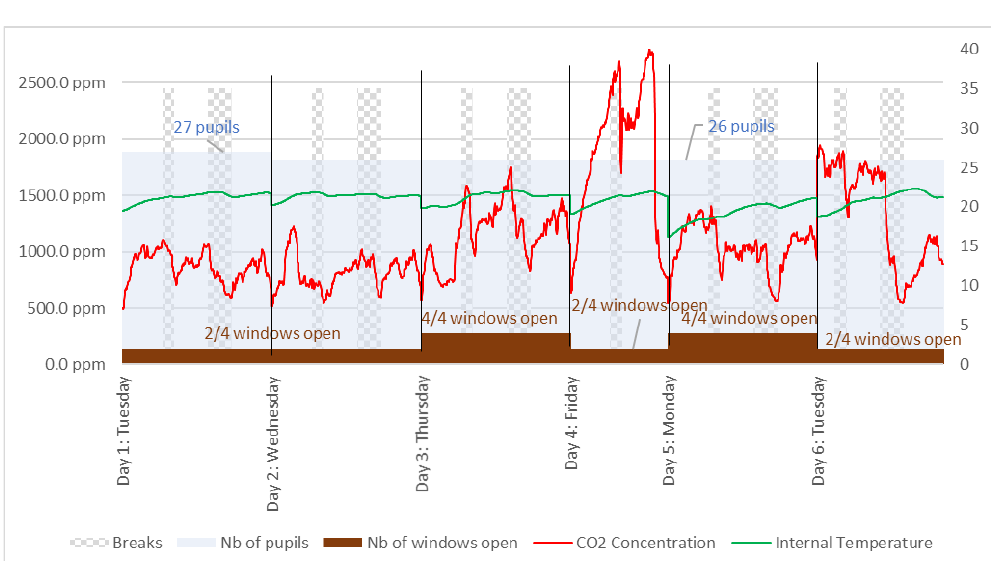
Figure 27. Temperature and CO 2 in B2 over the study week (pupils in school: 6 h 30 min per day Monday to Thursday and 4 h 30 min on Fridays).